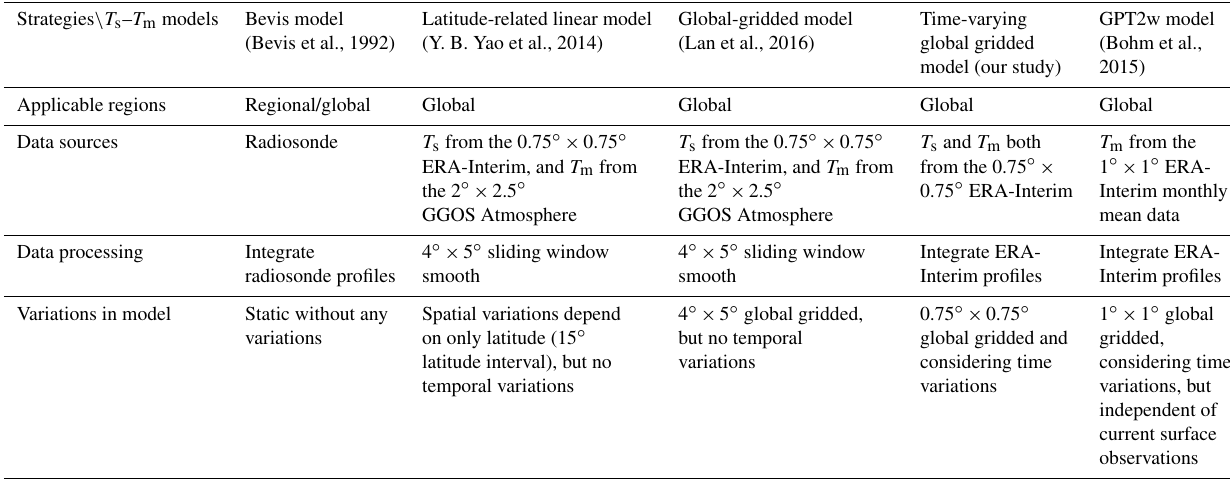
Table 1. Main differences between T s and T m models developed in this study and other global used T m estimation models. Strategies \ T s – T m